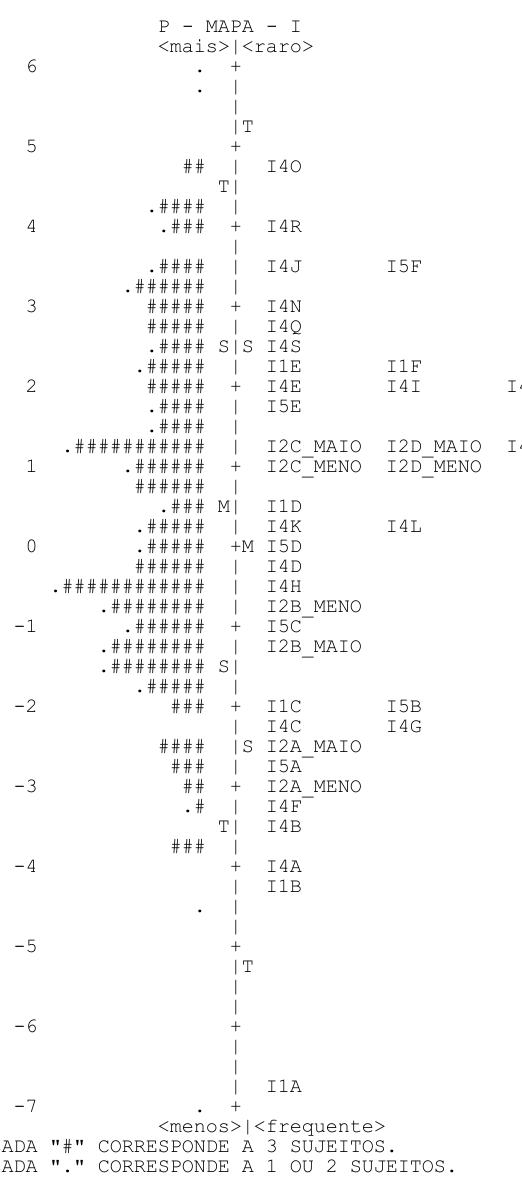
Figura 1 . Mapa de itens.